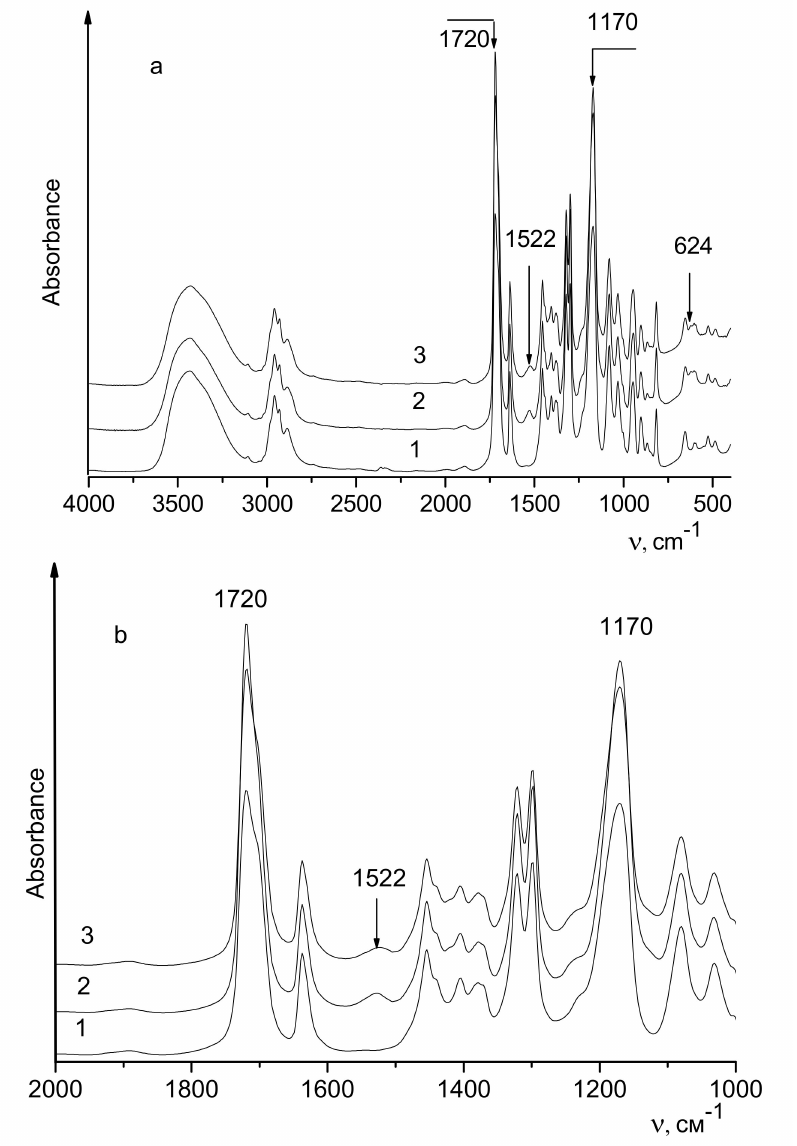
Figure 1. FTIR spectra ( a , b ) of HEMA (1) and poly(titanium oxide) in HEMA at molar ratio Ti(OPr i ) 4 to H 2 O: 1/1 (2) and 1/2 (3).